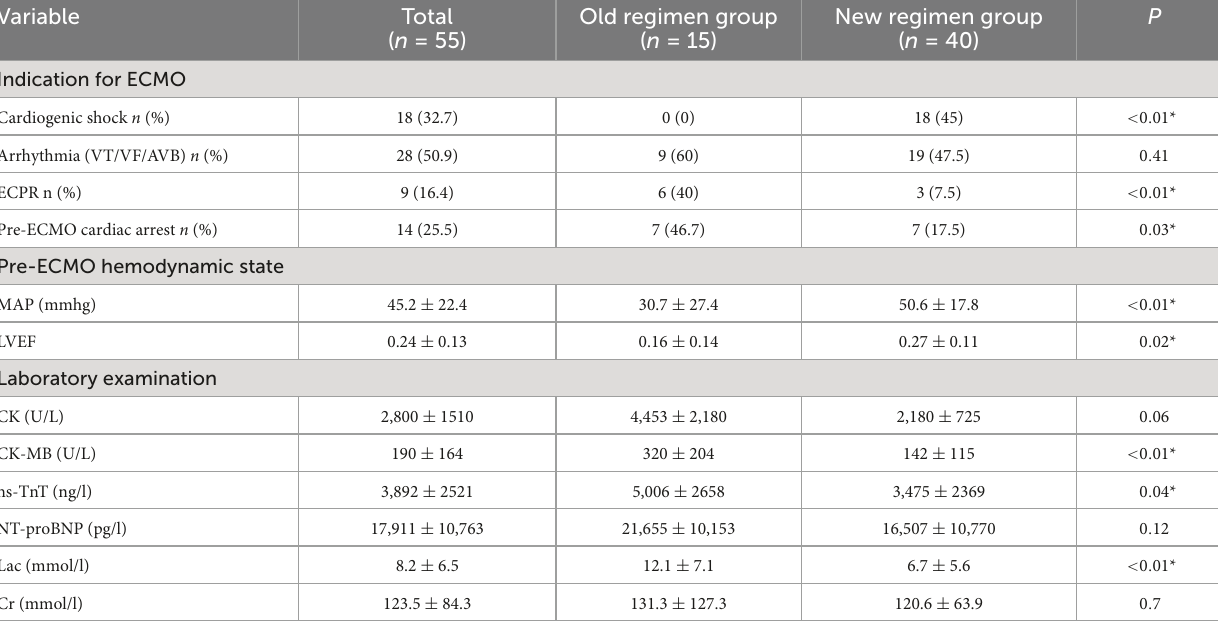
ECMO,extracorporealmembraneoxygenation;VT,ventriculartachycardia;VF,ventricularfibrillation;AVB,atrioventricularblock;ECPR,extracorporealcardiopulmonaryresuscitation;MAP, mean arterial pressure; LVEF, left ventricular ejection fraction; CK, creatine kinase; CK-MB, creatine kinase muscle/brain; hs-TnT, human hypersensitive troponin; NT-proBNP, N-terminal pro-Btypenatriureticpeptide;Lac:lacticacid;Cr:creatinine;* P < 0.05.